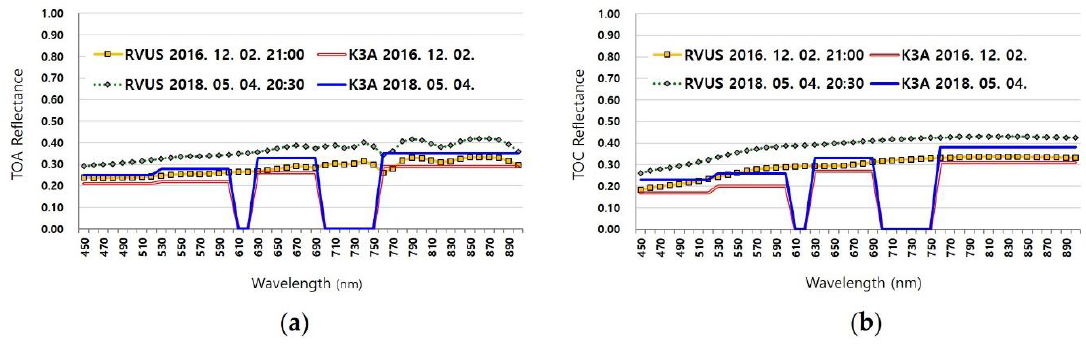
Figure 2. Comparison between the RadCalNet data from the RVUS site and the KOMPSAT-3A reflectance products: ( a ) Top-of-Atmosphere (TOA) and ( b ) Top-of-Canopy (TOC) reflectance data, both collected between 2 December 2016 and 4 May 2018. Table 1. KOMPSAT-3A TOA and TOC reflectance products and RadCalNet data from the RVUS site collected between 2 December 2016 and 4 May 2018.